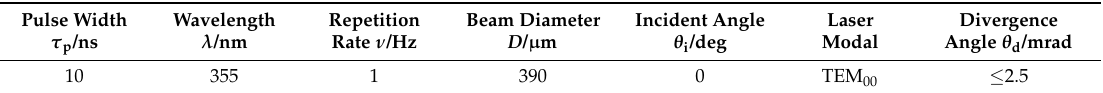
Table 3. The experimental parameters for laser damage test on fused silica.